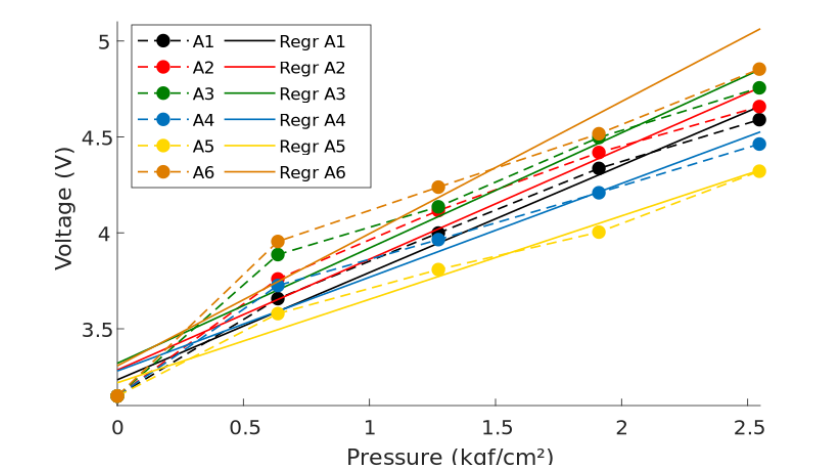
Figure 8. Linearization of the six pressure sensors. The dotted lines represent the obtained voltages, and the solid lines represent each sensor’s linear